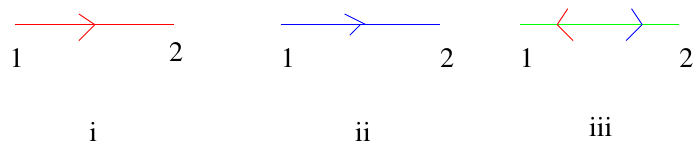
Figure 13 . (i) @ 2 G 12 = (cid:0) @ 1 G 12 , (ii) (cid:22) @ 2 G 12 = (cid:0) (cid:22) @ 1 G 12 and (iii) @ 1 (cid:22) @ 2 G 12